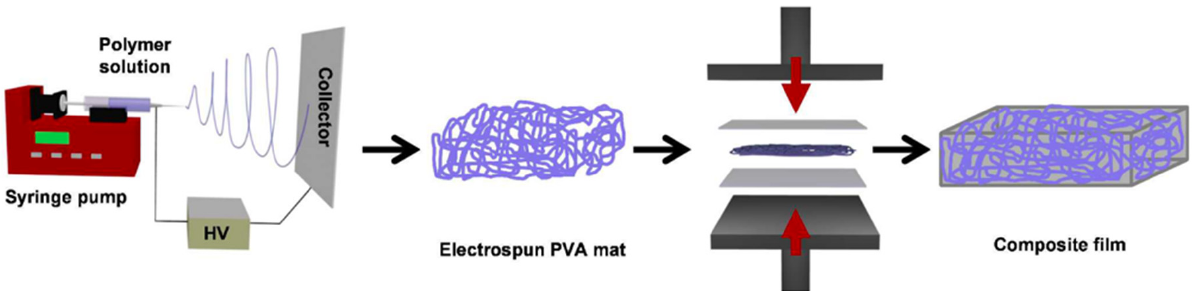
Figure 11. Representation of the production process of PEBA/PVA composite. Reprinted with per- mission from [94]. Copyright 2016 American Chemical Society.